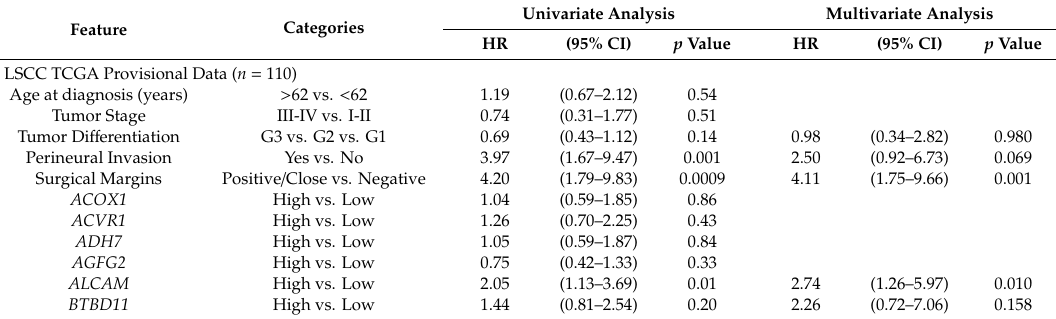
Table 2. Survival analyses pointed out ALCAM gene expression as independent prognostic factor in